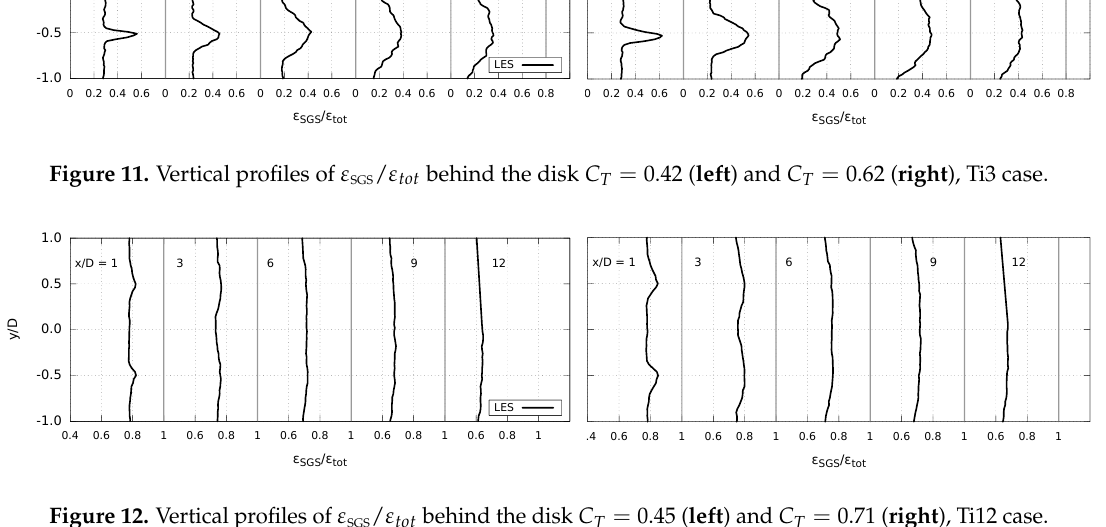
Figure 12. Vertical profiles of ε / ε tot behind the disk C T = 0.45 ( left ) and C T = 0.71 ( right ), Ti12 SGS